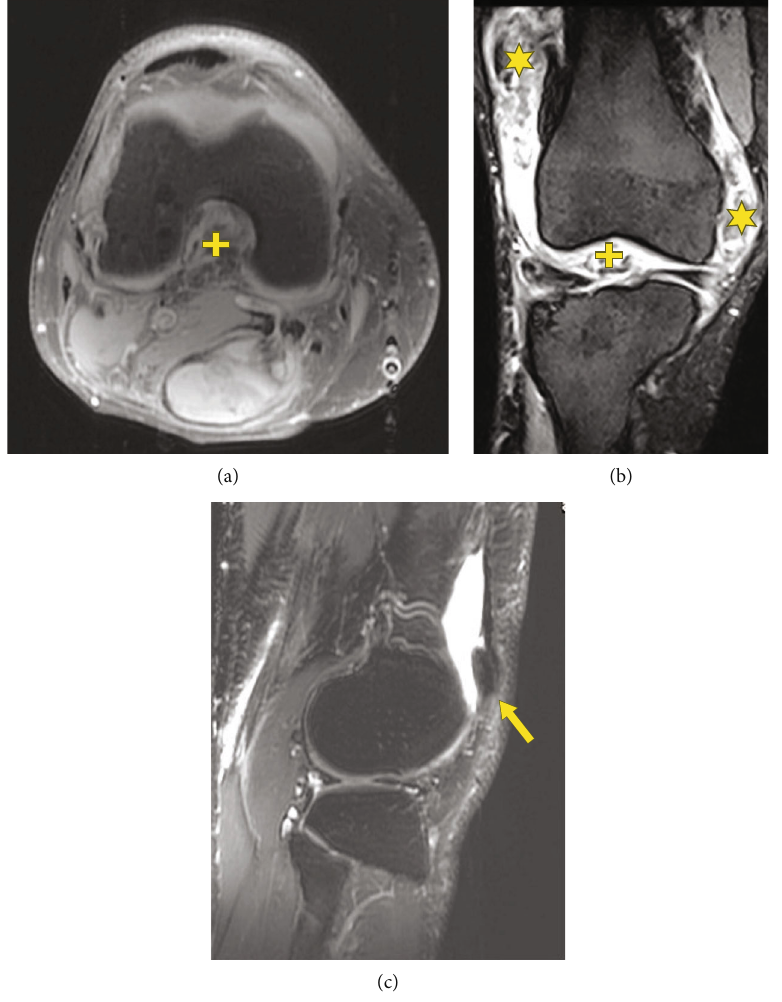
Figure 12: Axial, coronal, and sagittal images of a 55-year-old male with D-TGCT in the knee. MRI shows tumor measuring 2 : 8 cm × 1 : 4cm was in the medial and lateral gutters (star) along with tumor in the intercondylar notch posteriorly (plus). There were also synovial thickened nodules extending into the popliteal cyst, which shrank to 5.8cm and contained hypointense debris and hemorrhage (arrow). (a) An axial fat suppressed image of the distal femur, (b) a coronal T2 fat suppressed image of the knee, and (c) a sagittal T2 fat suppressed image of the lateral aspect of the knee joint that best demonstrated the residual tenosynovial giant cell tumor